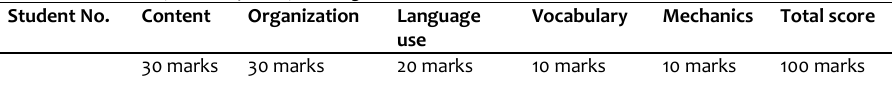
Table 1. Full Score of Each Aspect of Writing Student